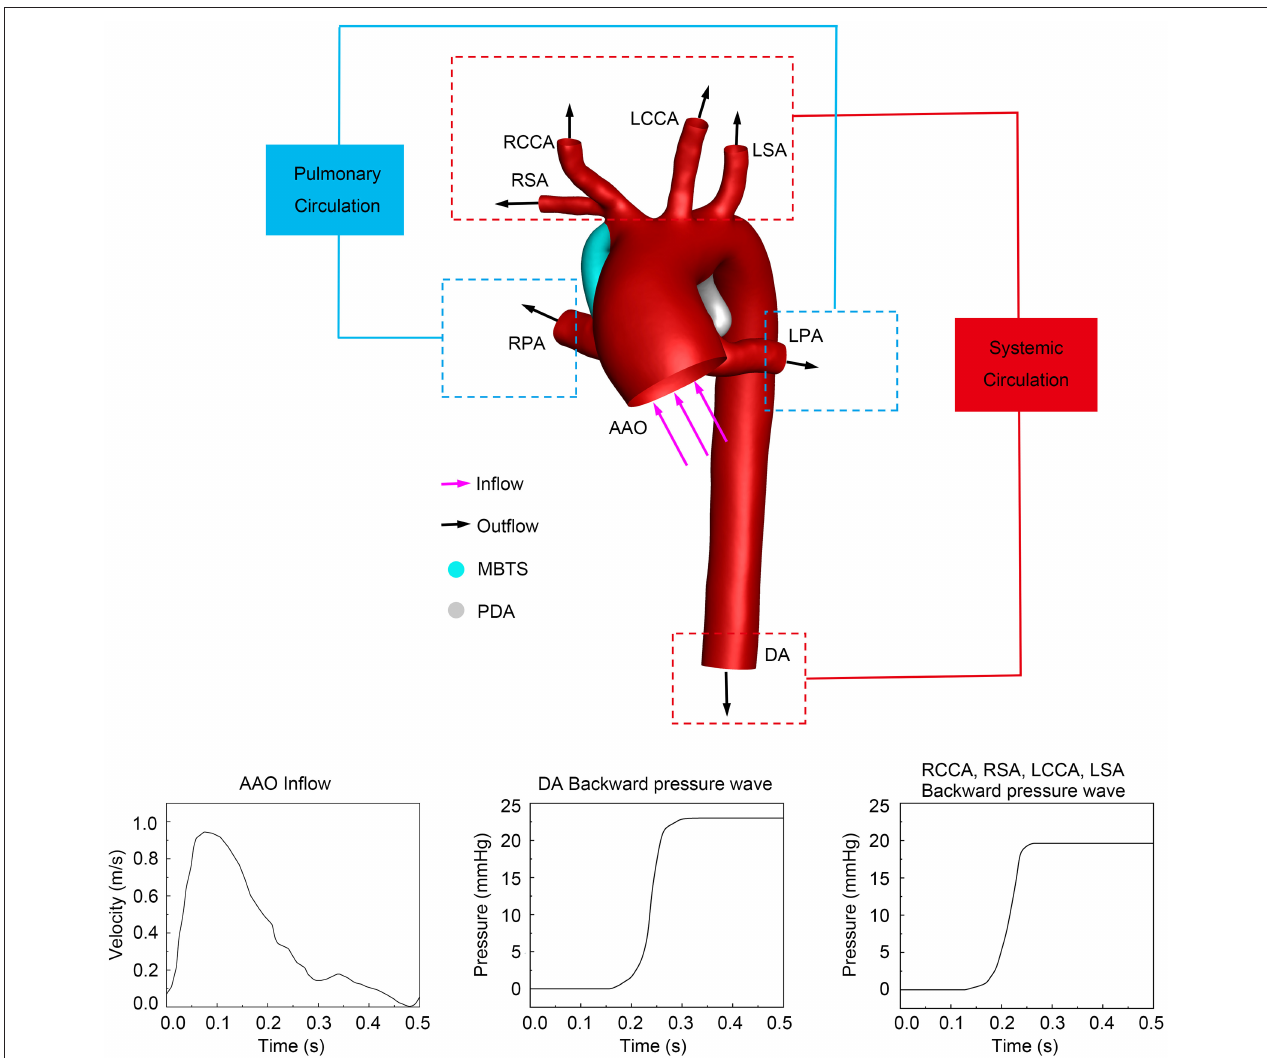
FIGURE 2 | The computational system and boundary conditions. The purple arrows represent the direction of inflow, and the black arrows indicate the direction of outflow. The inlet pulsatile velocity and the backward pressure waves in different outlets are shown at the bottom. PDA, patent ductus arteriosus; MBTS, modified Blalock-Taussig shunt; AAO, ascending aorta; DA, descending aorta; RSA, right subclavian artery; RCCA, right common carotid artery; RPA, right pulmonary artery; LCCA, left common carotid artery; LSA, left subclavian artery; LPA, left pulmonary